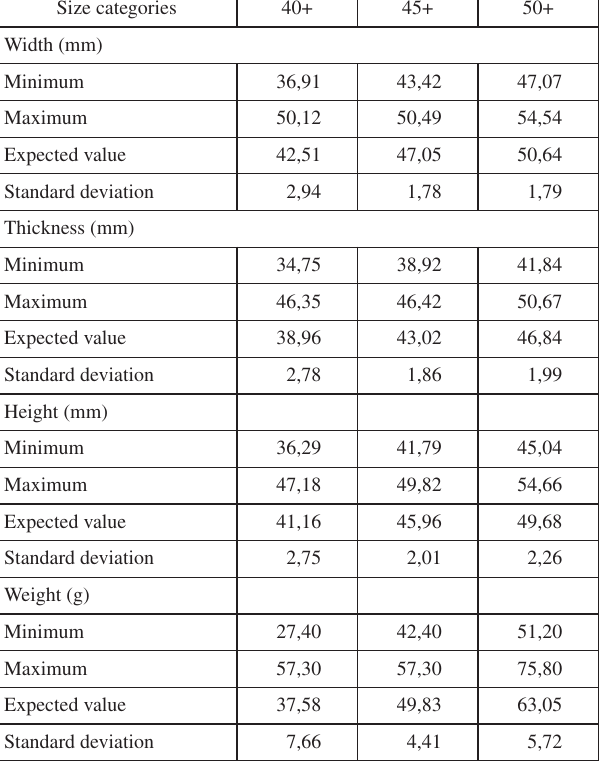
Fig. 12: Template for size category assignments